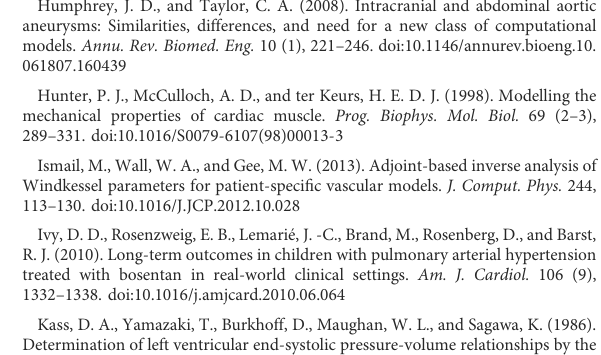
Figueroa, C. A., Vignon-Clementel, I. E., Jansen, K. E., Hughes, T. J. R., and Taylor, C. A. (2006). A coupled momentum method for modeling blood fl ow